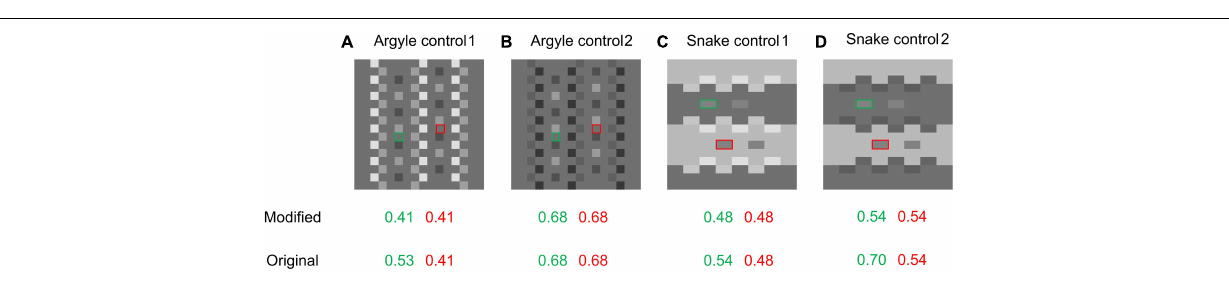
FIGURE 10 | Variants of Argyle and Snake-illusion figures and the models’ predictions. Green and red frames indicate the target areas. (A) Argyle control 1; the darkest pixels in the original Argyle ( Figure 2 ) are moderately brightened. (B) Argyle control 2; the brightest pixels are darkened. (C) Snake control 1; the darkest pixels in the original Snake ( Figure 2 ) are brightened. (D) Snake control 2; the brightest pixels are